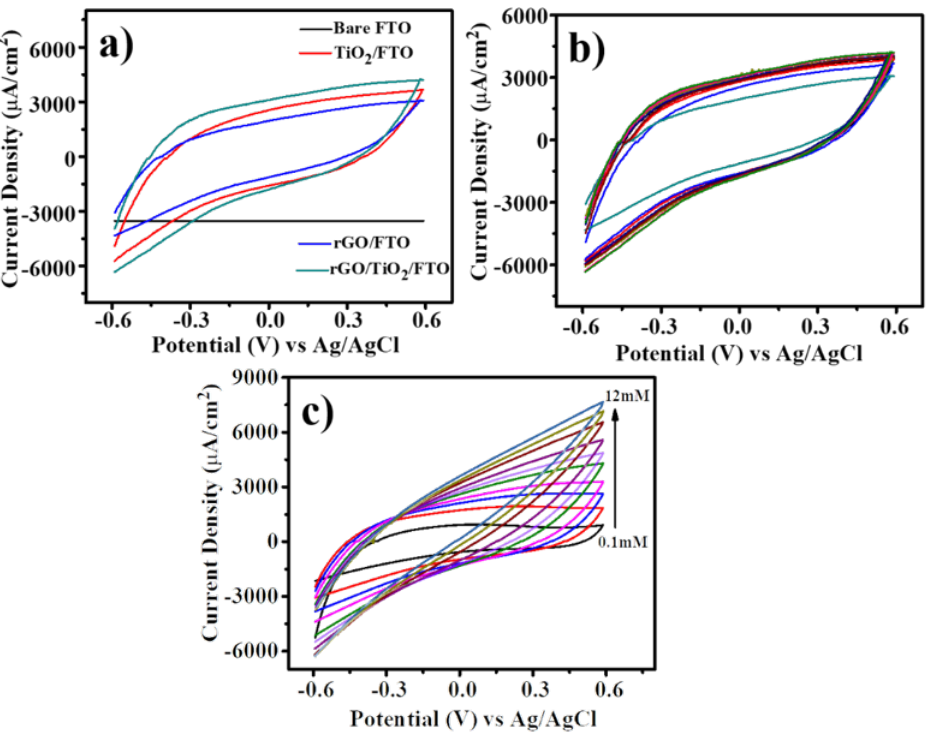
Figure 5. ( a ) CV response of various electrodes, ( b ) Effect of variable scan rate on rGO/TiO 2 /FTO electrode, and ( c ) Effect of variable glucose concentration on rGO/TiO 2 /FTO electrode.